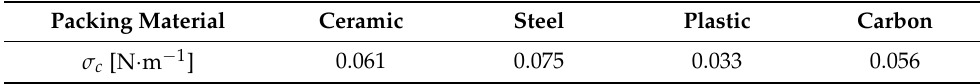
Table 1. Critical surface tension for different packing materials [46]. Packing